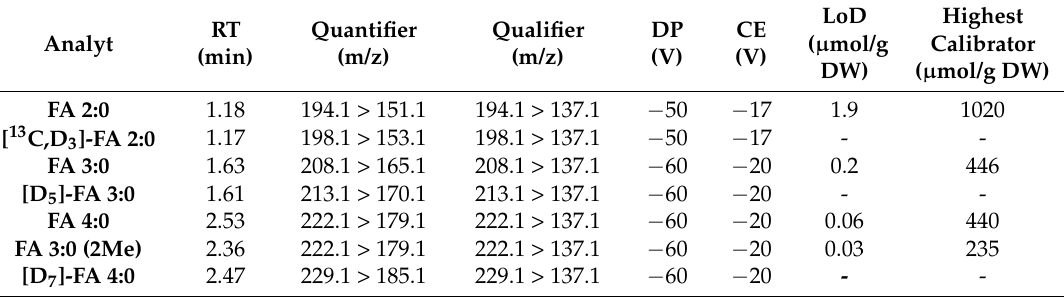
Table 1. LC-MS/MS of the short chain fatty acid (SCFA)–3-nitrophenylhydrazones (3NPH) derivatives. Displayed are the retention time (RT), mass transitions (quantifier and qualifier ions) of analytes and stable isotope labelled internal standards, declustering potential (DP), and collision energy (CE), as well as the limit of detection (LoD) and highest calibration level for the LC-MS/MS quantification of SCFA–3NPH